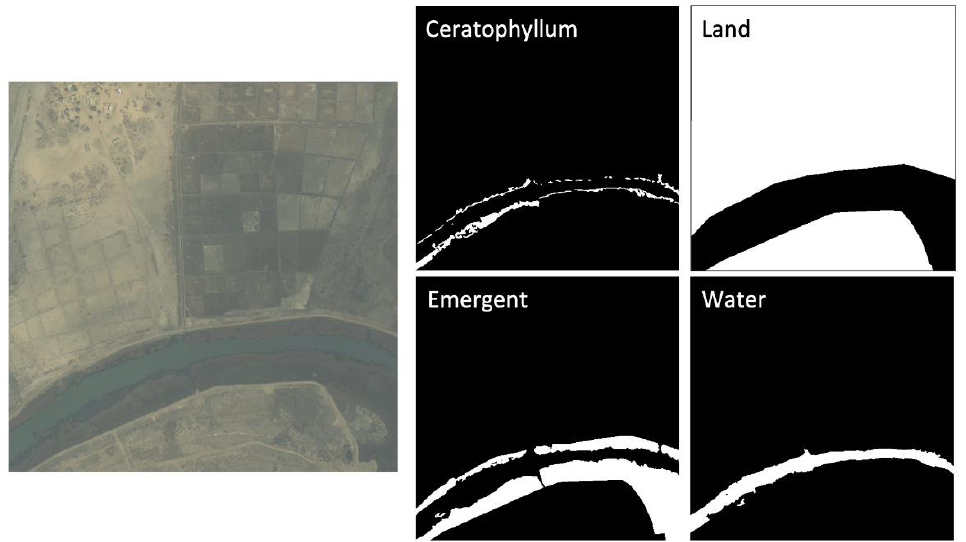
Figure 5. Example of label masks for a satellite image. The four classes are floating, emergent, water, and land’. Pixels are assigned a value of 1 (white color) if they belong to the assigned class, and a value of 0 (black color)